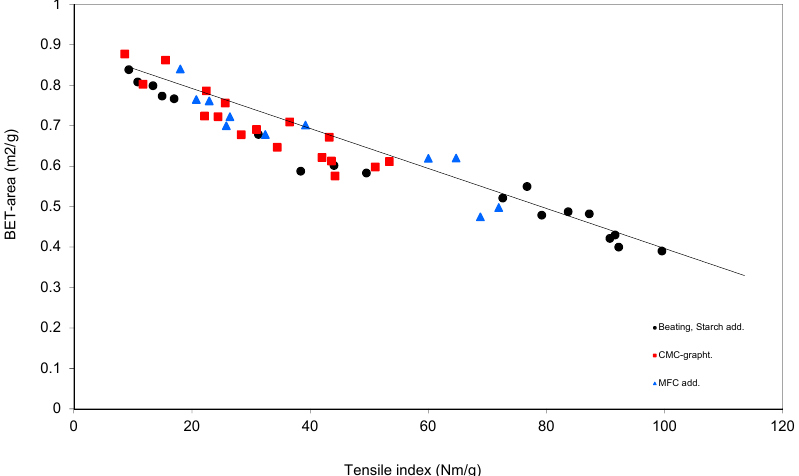
Figure 2. The relationship of the BET-area and the tensile index of nanocellulose films made from bleached paper pulp, when changing various dry strength agents (reproduced from Ref. [16] with permission from Royal Institute of Technology, Stockholm).